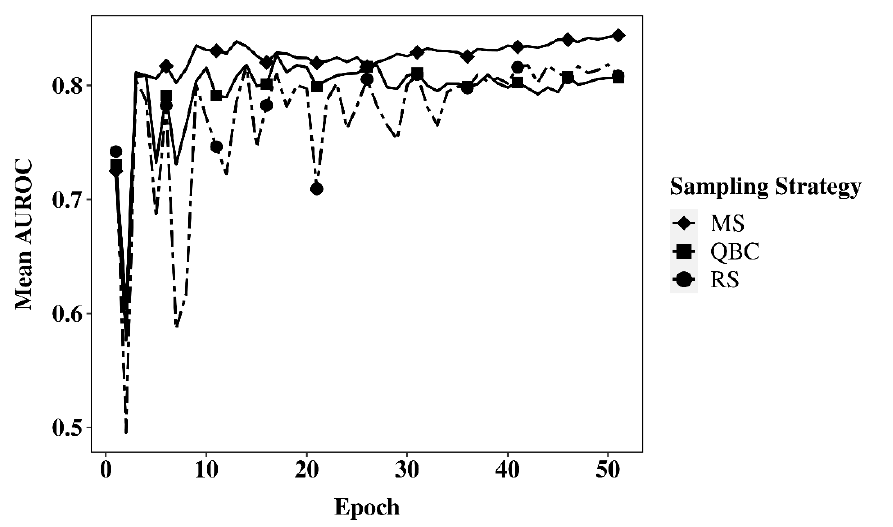
Figure 3. Performance versus epochs: mean AUROCs of SVMs across all 150 repetitions for different sampling methods in the target area.